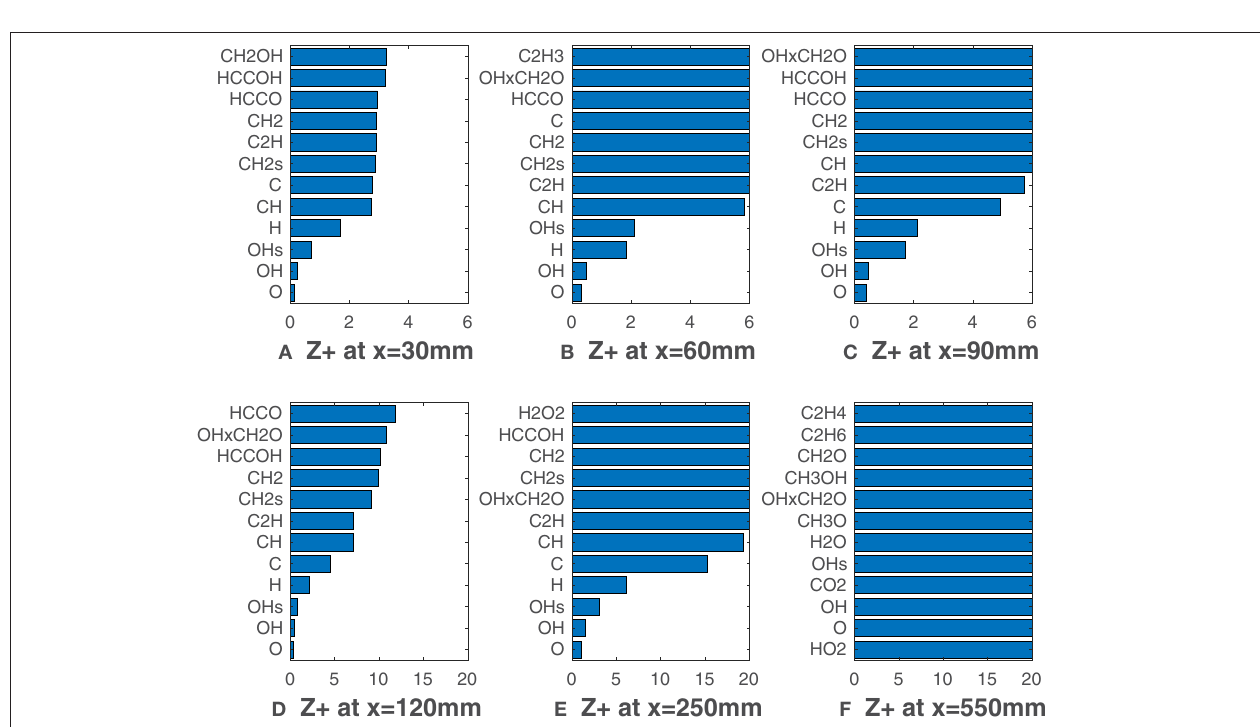
FIGURE 4 | HM1 case: best correlated net reaction rates at various axial locations. Lower Z + s ( ˙ ω r ) values mean better correlation.